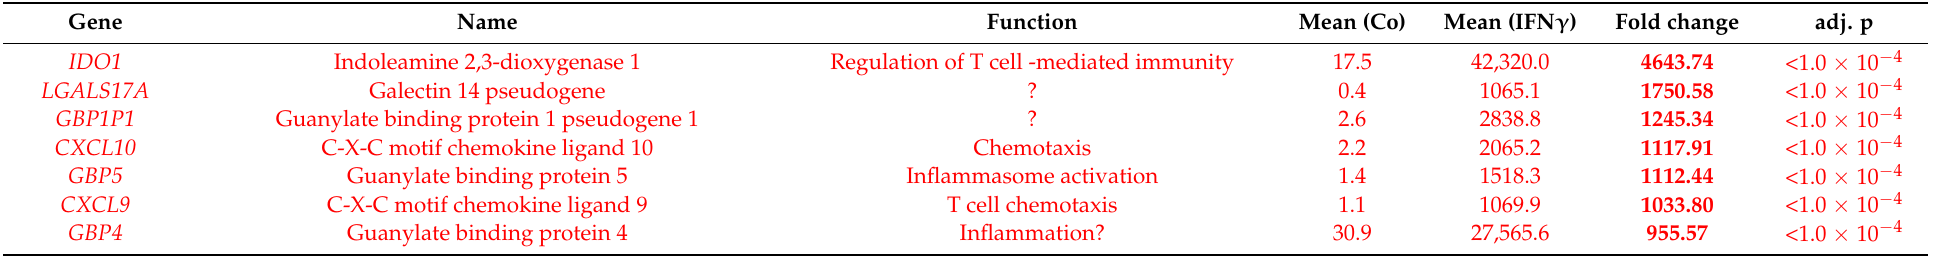
Table 3. Twenty most strongly up- and downregulated genes in interferon gamma -treated OA chondrocytes (IFN γ ) relative to control